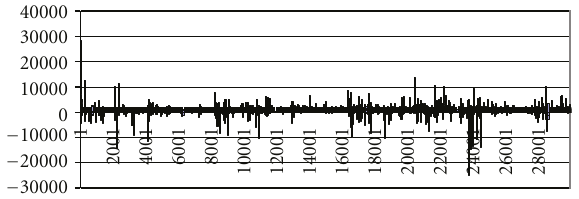
Figure 8: The sum of di ff erence B [1] ··· B [30000] for Lena image.